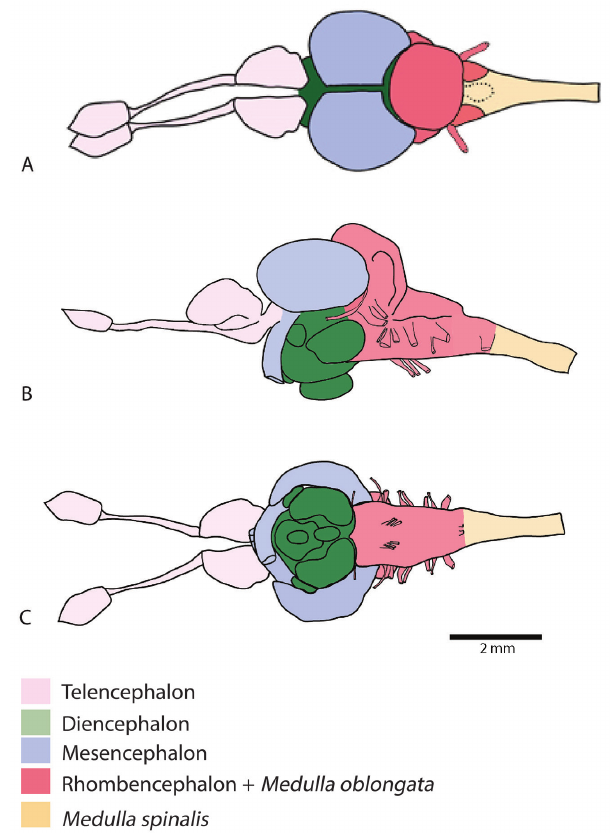
Fig. 1. Brain of Brycon orbignyanus (Characiformes: Bryconidae), LIRP 6309, 175.5 mm SL. Main encephalic divisons ( Telencephalon , Diencephalon , Mesencephalon , Rhombencephalon + Medulla oblongata and Medulla spinalis ) in different colors. a. dorsal; b. lateral and c. ventral